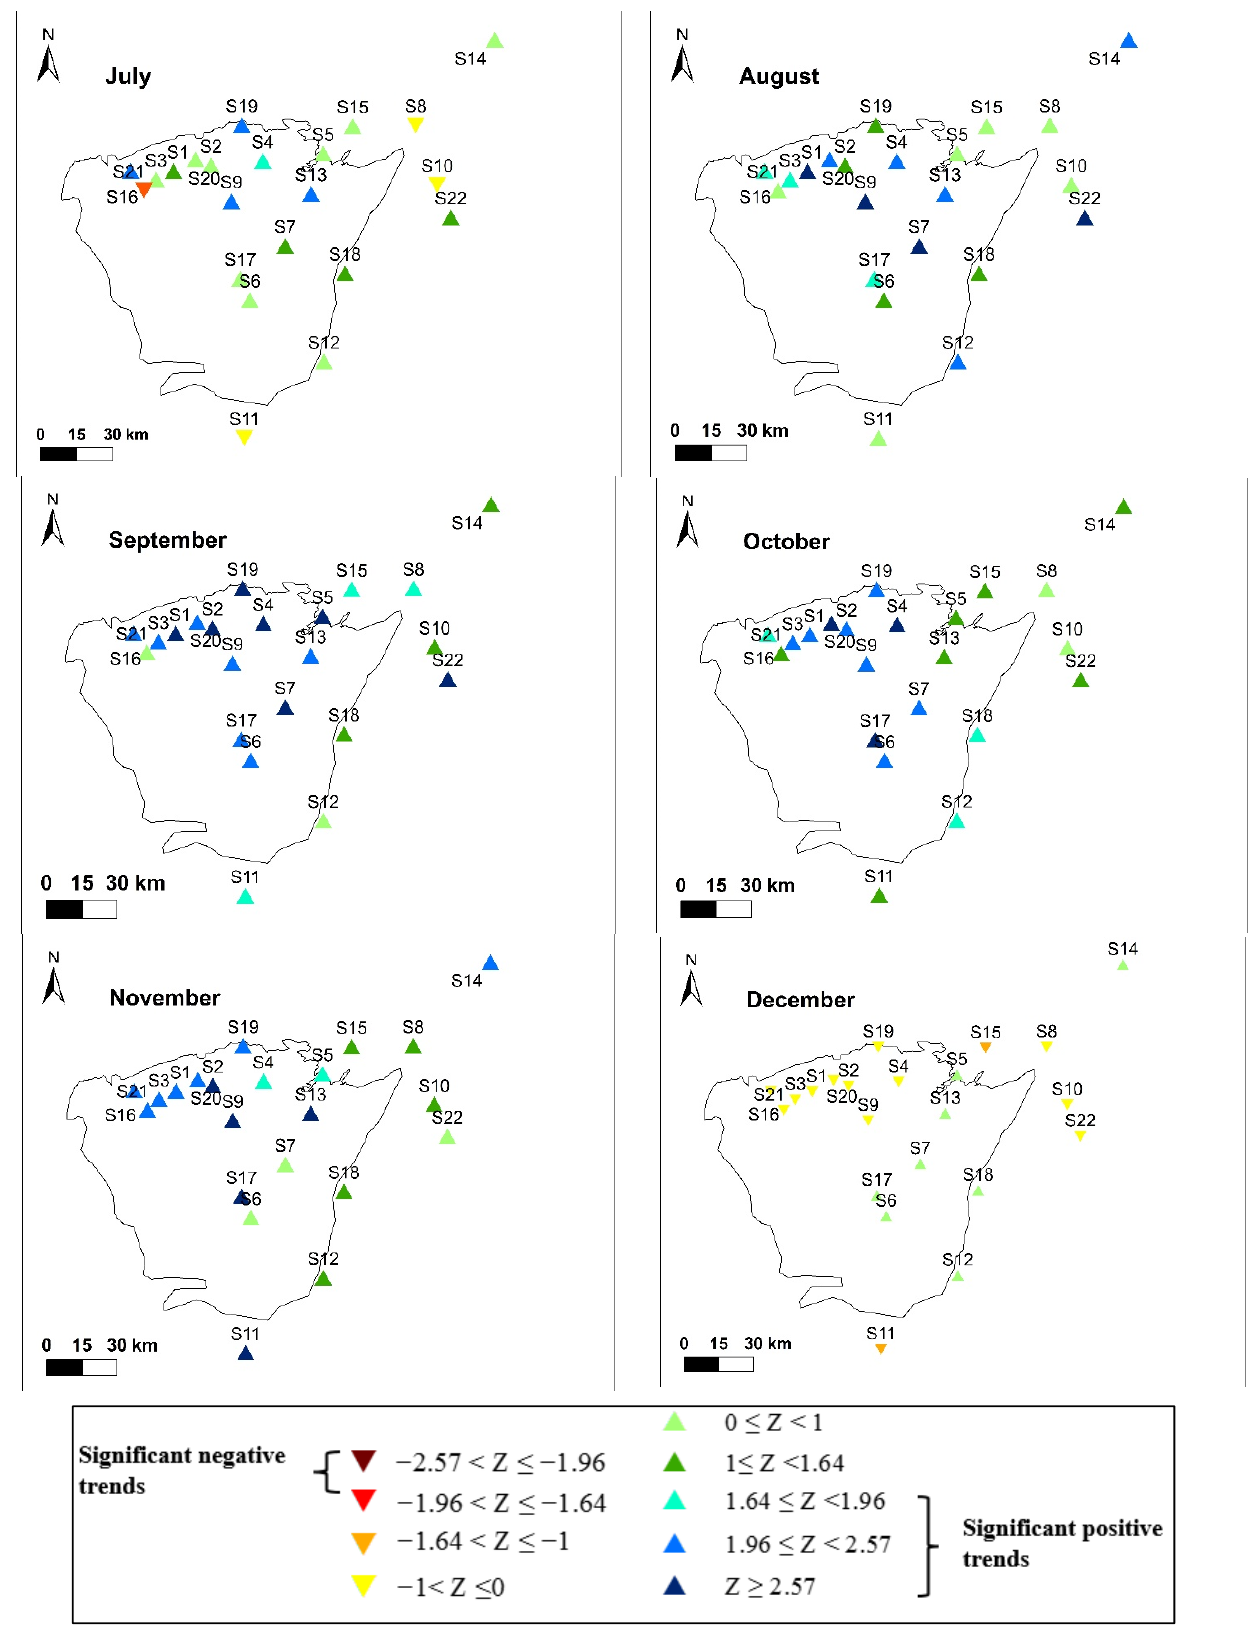
Figure 8. Spatialization of monthly precipitation trends of all data series.